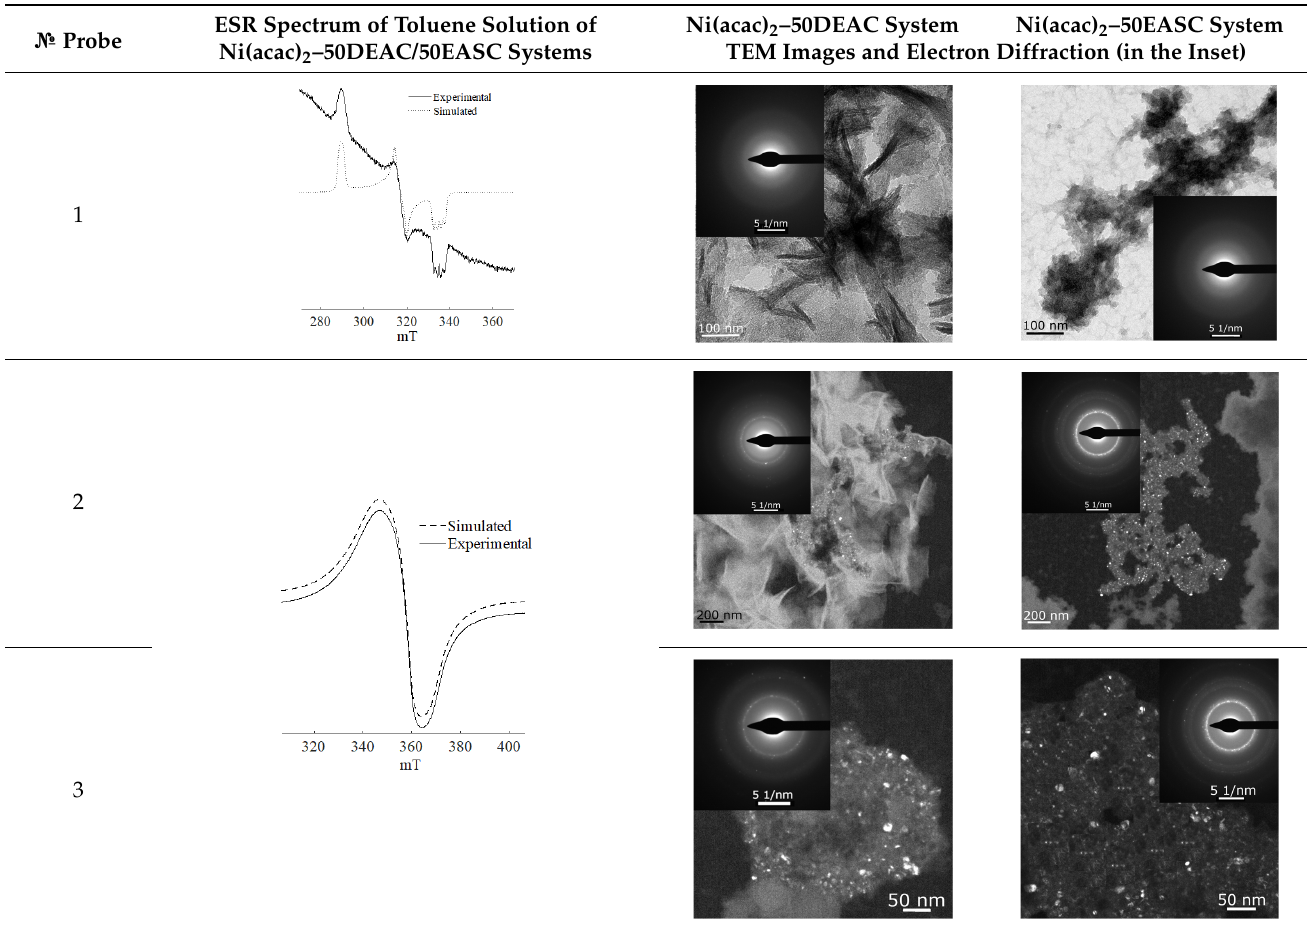
Table 3. Interplanar distances obtained during analysis of the atomic profiles and electron diffrac- tion of Ni(acac) 2 –DEAC and Ni(acac) 2 –EASC samples presented in Table 2 (point 2). Data were taken from ref. [13,17].